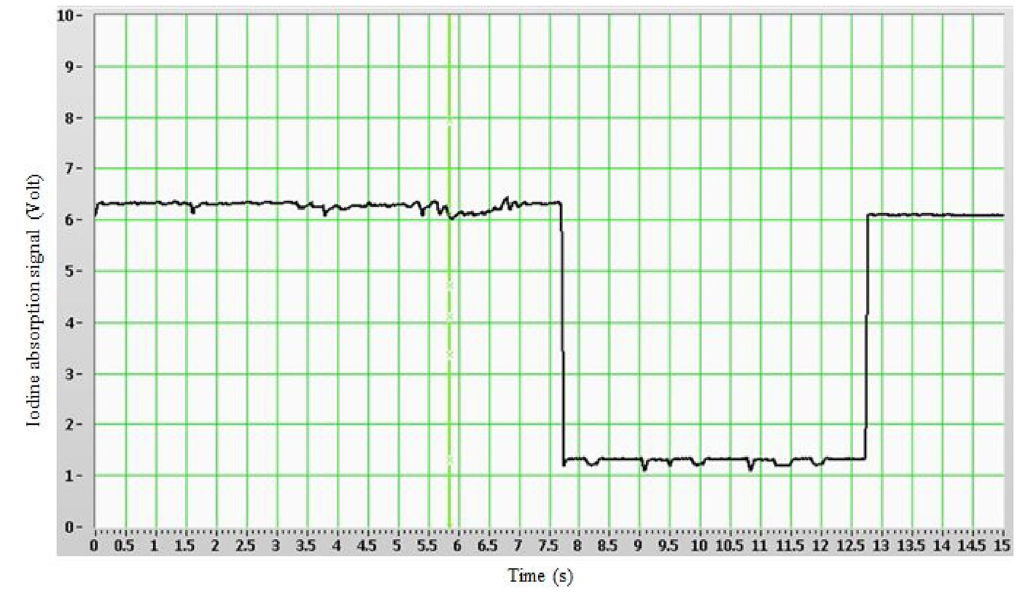
Figure 5. Temporal variation of Iodine absorption